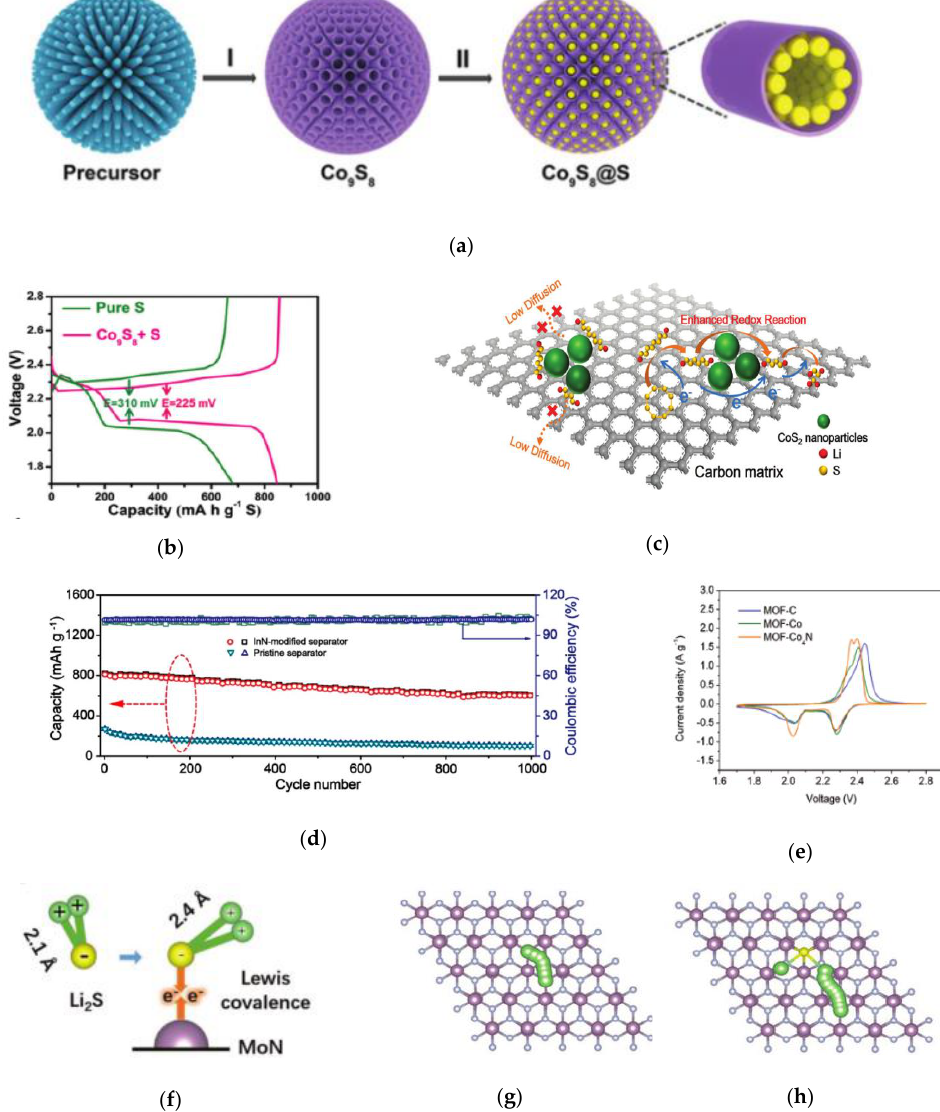
Figure 5. ( a ) Schematic illustration of the fabrication of S@Co 9 S 8 composites [41]. ( b ) Discharge–charge curves of S and Co 9 S 8 + S electrodes [41]. ( c ) The role of CoS 2 nanoparticles on polysulfides capture and conversion [42]. ( d ) Long-term cycling performance of Li − S batteries at 1.0 C after 1000 cycles [44]. ( e ) The second cycle of CV [45]. ( f ) Representation of the covalence-activation mechanism on MoN [46]. ( g ) Li ion di ff usion path and ( h ) Li 2 S decomposition path on MoN. The Li, S, Mo, and N atoms are denoted by green, yellow, purple, and gray balls, respectively